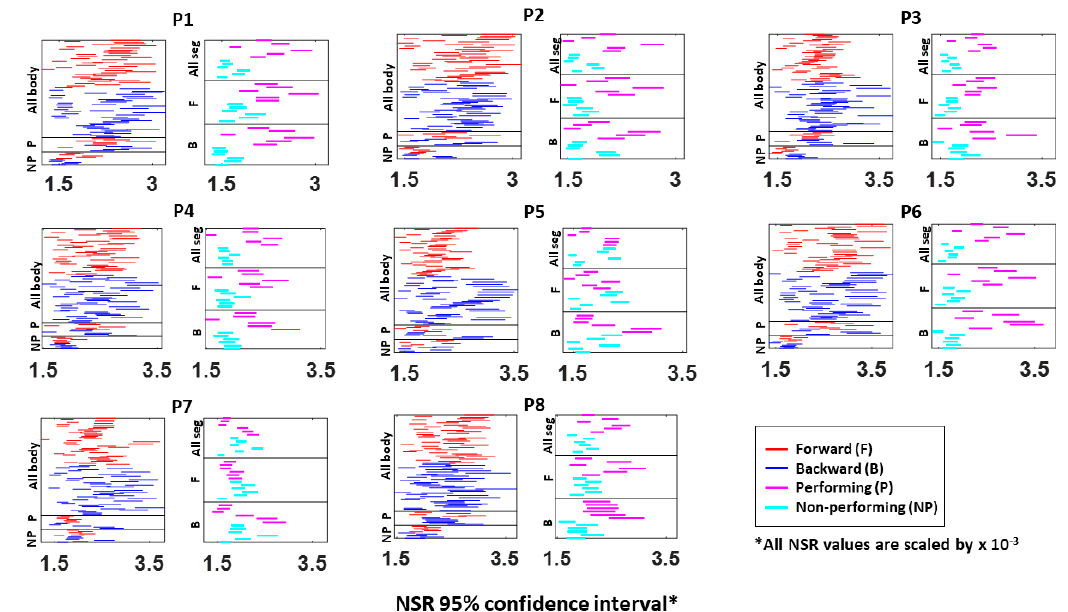
Figure A4. Fitted Gamma scale parameter (i.e., NSR) 95% confidence interval from the absolute difference in kinematics between pairs of body parts. The 95% confidence interval is plotted for all eight participants (P1 to P8). Each row represents a pair of body part: under the “All body” category shows all 45 body part ( 10 C 2 ) pairs during forward (red) and backward (blue) motions; under the “P (performing)” category shows the 6 body part pairs ( 4 C 2 ) from the performing side of the arm; under the “NP (non-performing)” category shows the 6 body parts pairs ( 4 C 2 ) from the non-performing side of the arm; under the “All seg (all segment)” category shows the 6 body parts pairs ( 4 C 2 ) on the performing (pink) and non-performing (cyan) side during the entire pointing motion; under the “F (forward)” category shows the 6 body parts pairs ( 4 C 2 ) on both P and NP side during forward motion; and under the “B (backward)” category shows the 4 body parts on both P and NP side during backward motion.